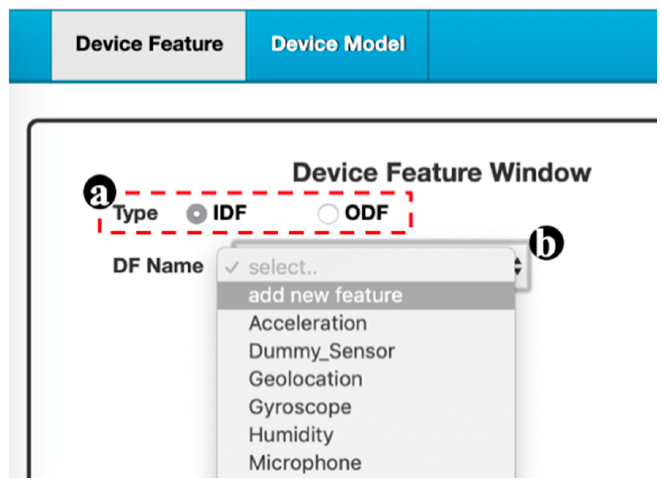
Figure A2. Device feature window.